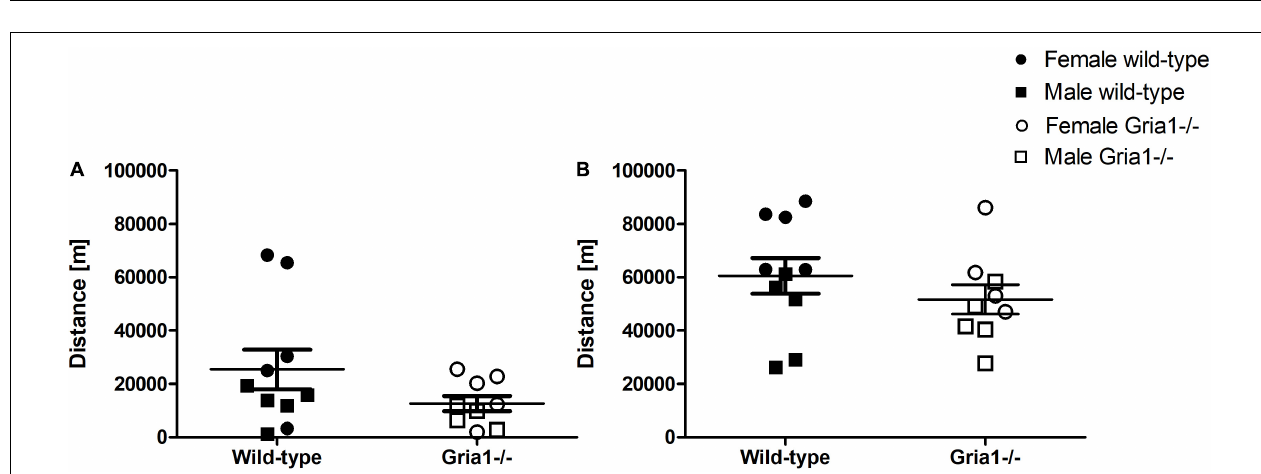
FIGURE 4 | Voluntary wheel running. The analysis of voluntary wheel running performance, assessed in prepubescent (A) and again in sexually mature mice (B) , showed no significant effects of genotype on the total distance moved. ANOVA. n = 4–5 per genotype per sex. Error bars indicate the standard error of the mean